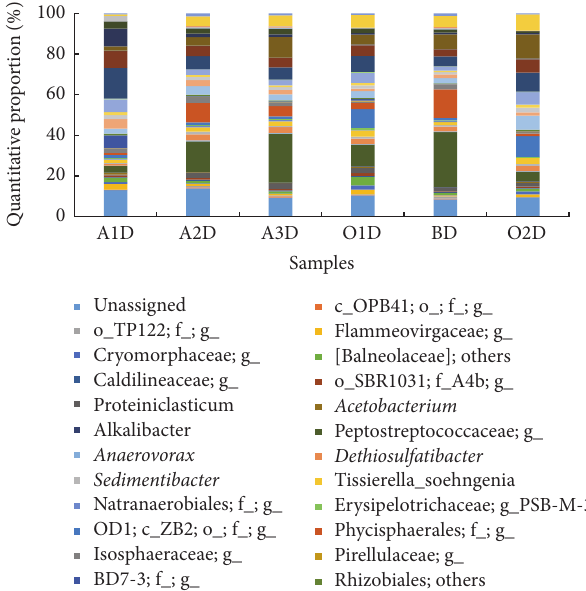
Figure 5: Microbial classification in the sludge samples according to family and